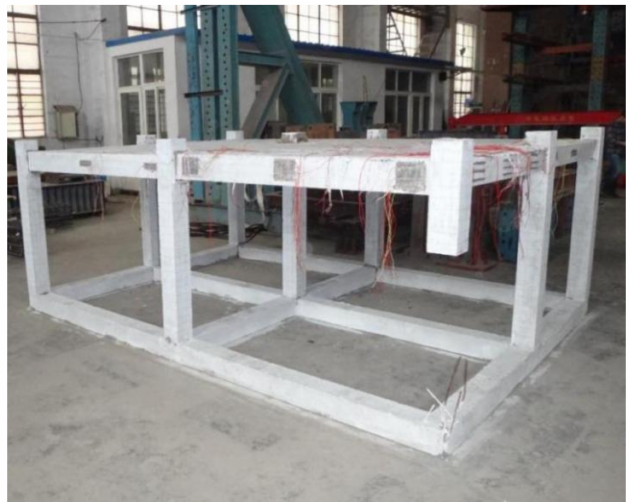
Figure 2. The aerial view of fabricated